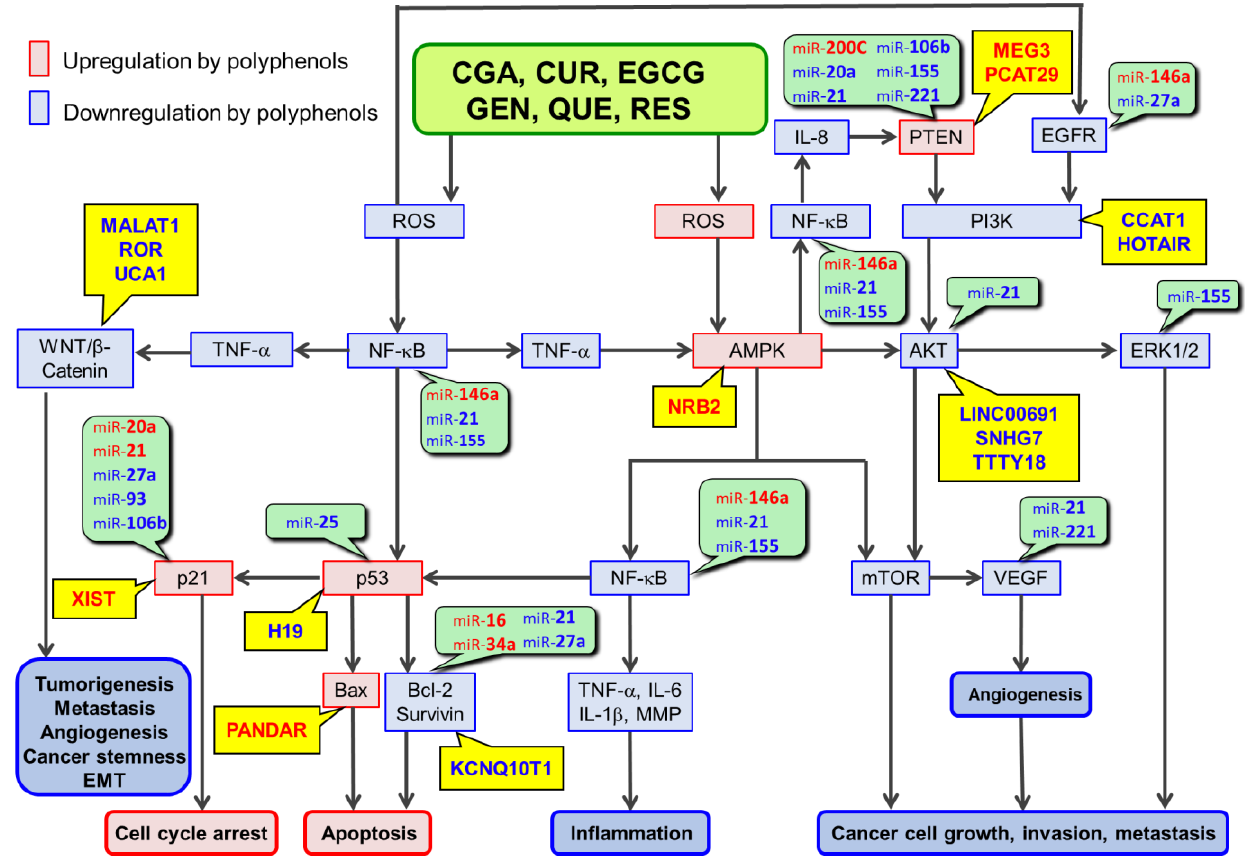
Figure 1. ROS-scavenger-triggered anticancer pathways (RSTAPs) and contribution of ncRNAs. lncRs upregulated and downregulated by polyphenols are in red and blue, respectively, on a yellow background. miRs upregulated and downregulated by polyphenols are in red and blue, respectively, on a green background.